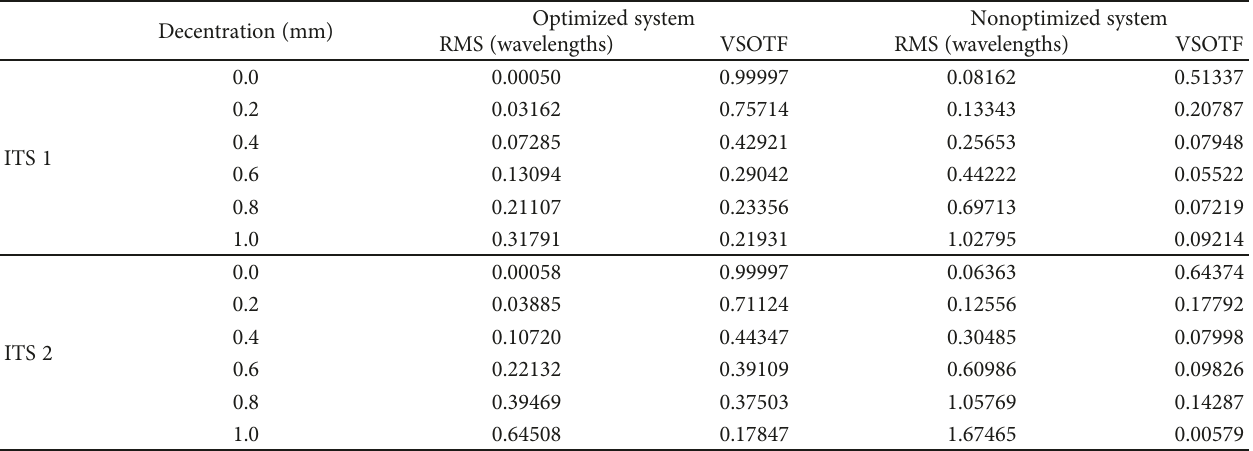
Table 2: Optical and visual results for both telescopic systems (near target distance).